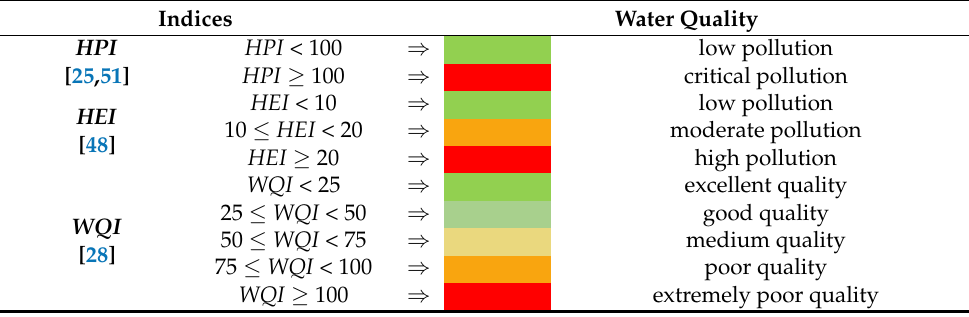
Table 2. Pollution indices used for water quality